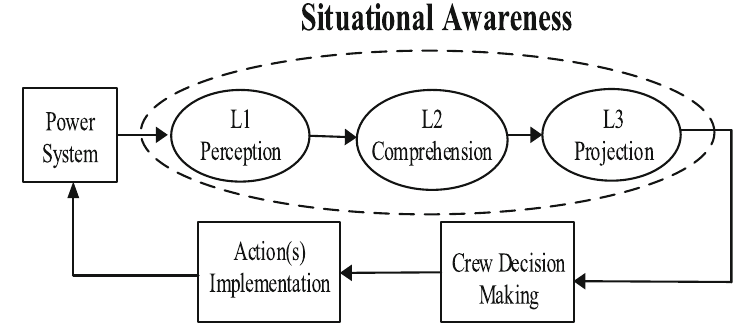
Fig. 1 Schematic model of SA in the power